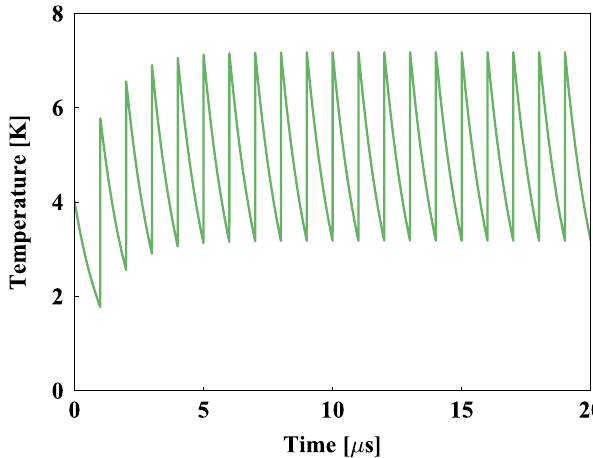
FIG. 10. Time histories of the averaged temperature (minus 70 K). The repetition rate is 1 MHz, and the periodic input laser pulse is the same as the single-pulse one.